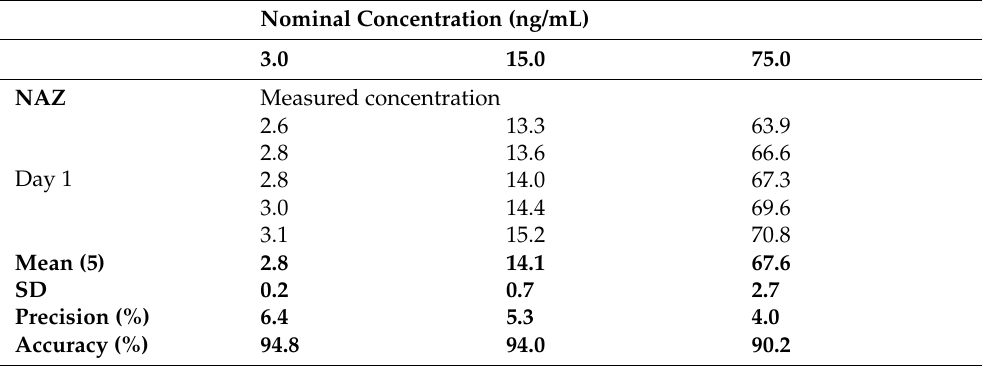
Table 3. Intraday precision and accuracy for NAZ in